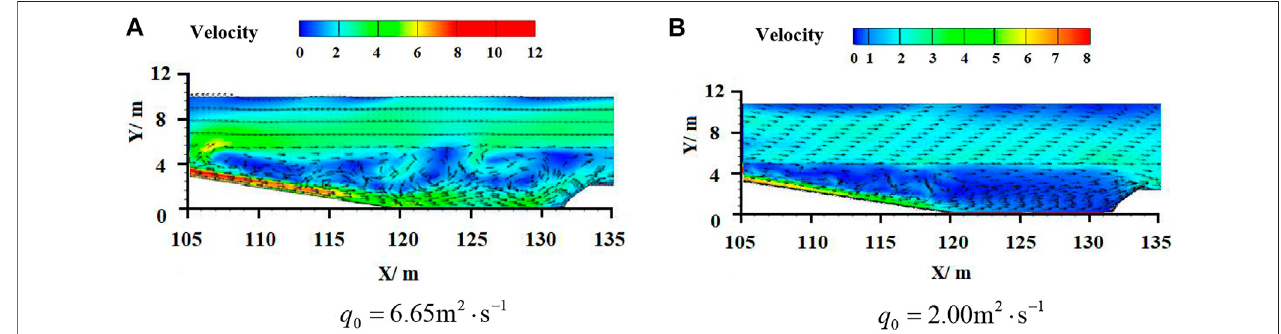
FIGURE 9 | Velocity vector at the bottom of the stilling basin (A,B) under different inlet unit width fl ows.